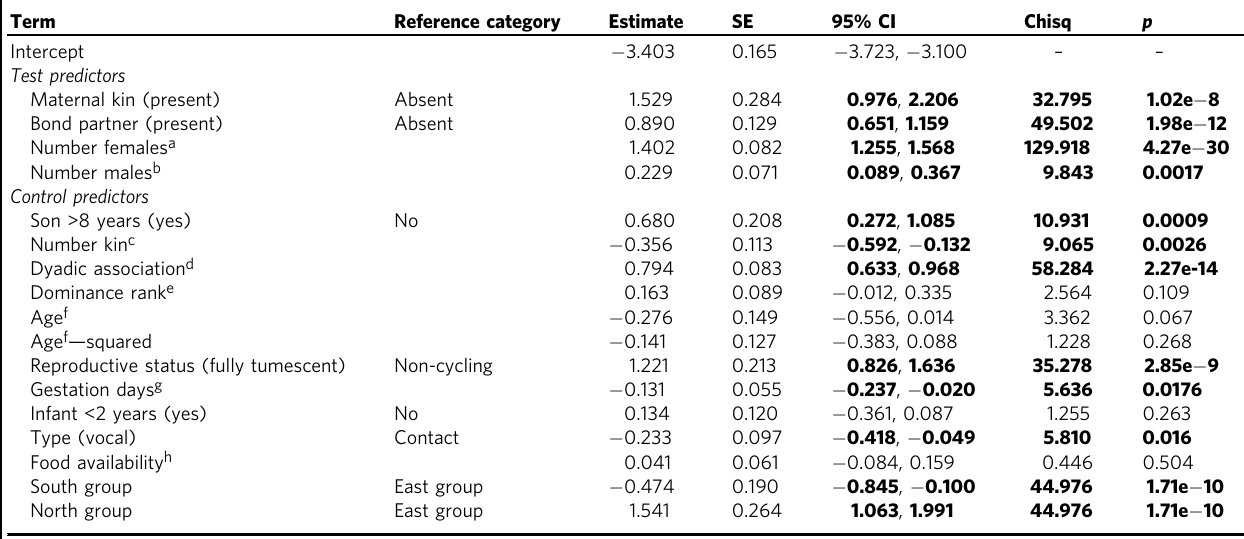
In bold appear the 95% CIs that do not overlap 0. The coded levels are indicated in parenthesis. a – h z -transformed, mean±SD of the original variables: a 5.03±3.57, b 3.43±1.54, c 1.51±1.02, d 0.51±0.19, e 0.55±0.29 (range 0-1 with 1 being the highest social rank), f 26.67±8.69, g 11.56±40.25, h 1.96 ±1.59.